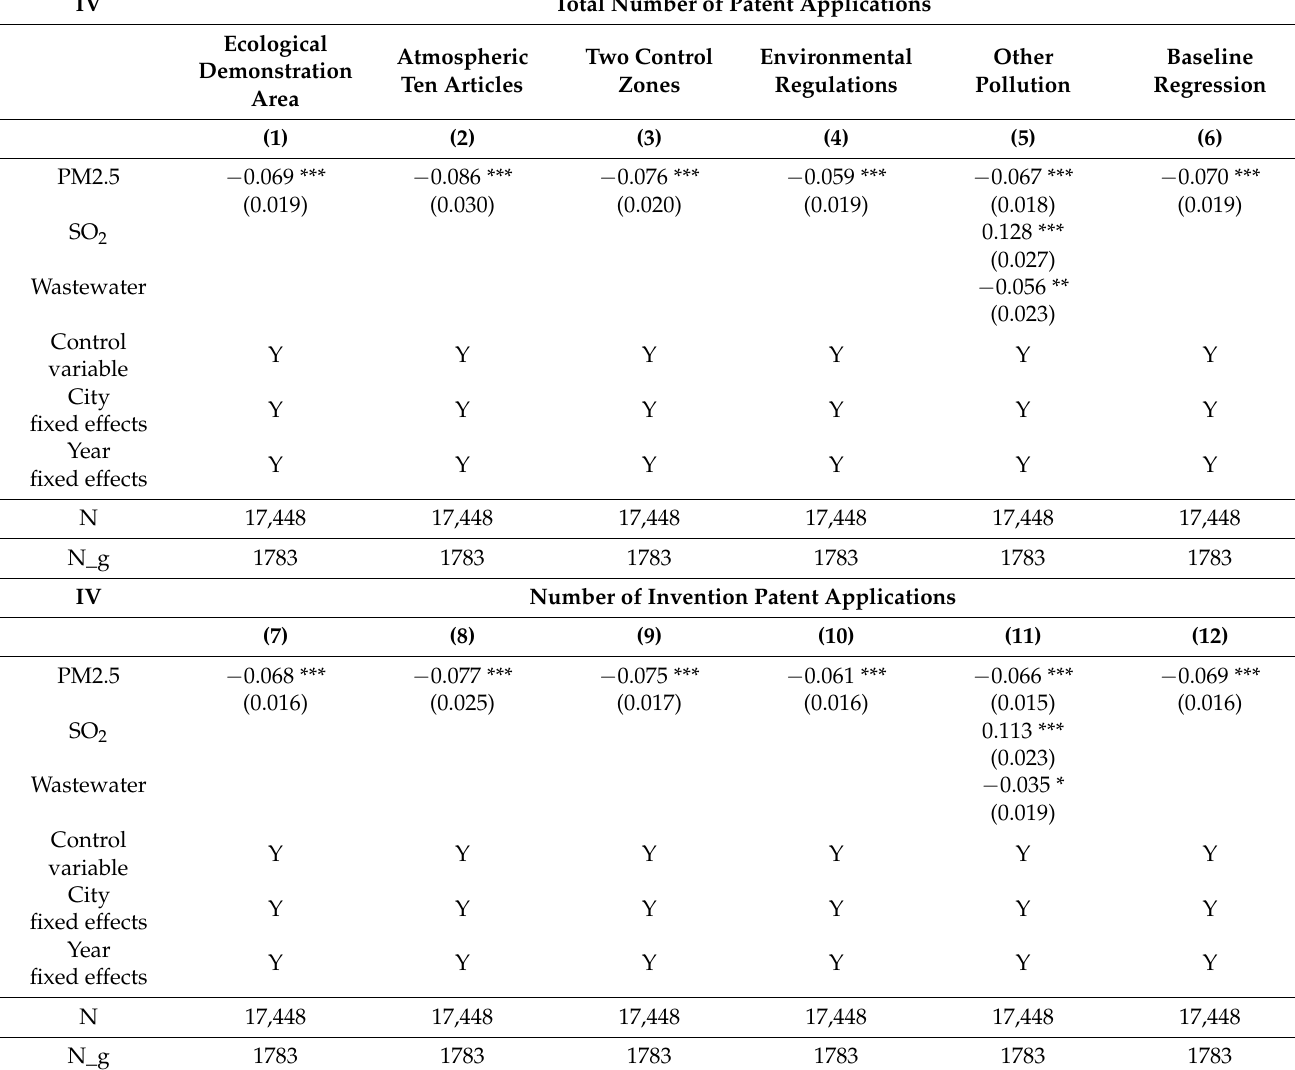
Table 9. Effect of environmental